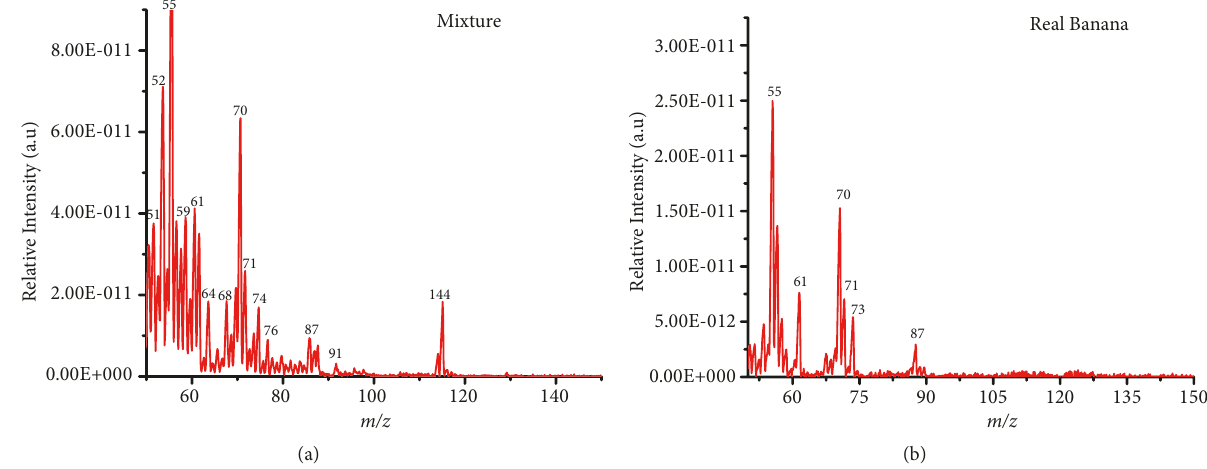
xx Limit of detection (LOD) was calculated as = 3.3(standard error/slope), taken from a calibration curve of five points in the range 250-1000 ppb with three repetitions for each point.